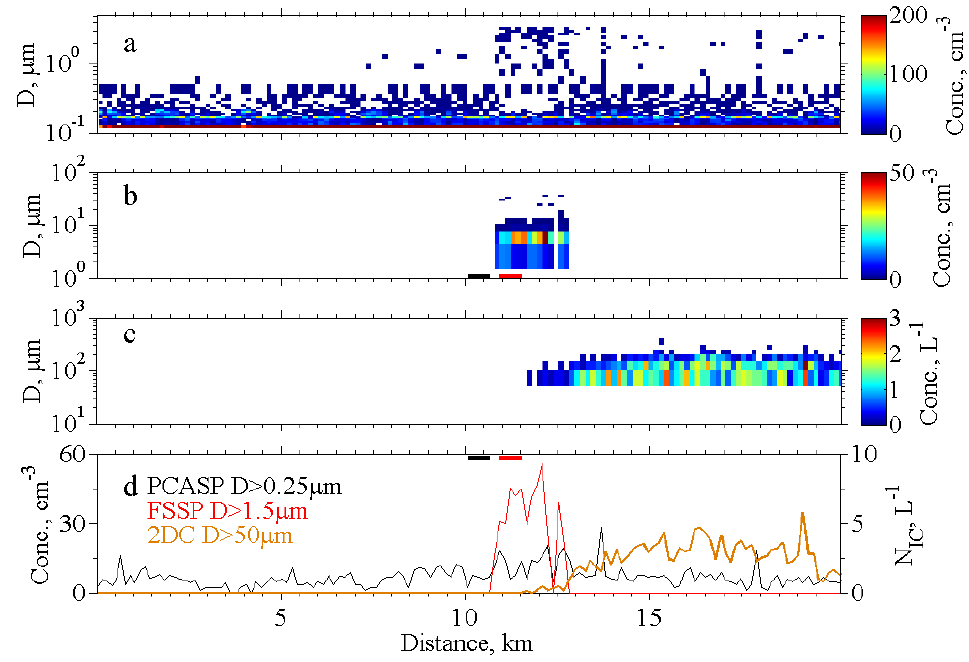
Figure 2. The same segment of flight as shown in Fig. 1. (a) Size-resolved PCASP concentrations. (b) Size-resolved FSSP concentrations. The black and red horizontal rectangles at the bottom of this panel are the five-second averaging intervals for aerosol and droplets analyzed in Sect. 3.3. (c) Size-resolved 2DC concentrations. (d) Diameter-integrated PCASP ( D > 0.25µm, black line), diameter-integrated FSSP ( D > 1.5µm, red line), and diameter-integrated 2DC ( D > 50µm, orange line) concentrations. Averaging intervals for aerosol and droplets are repeated from (b)